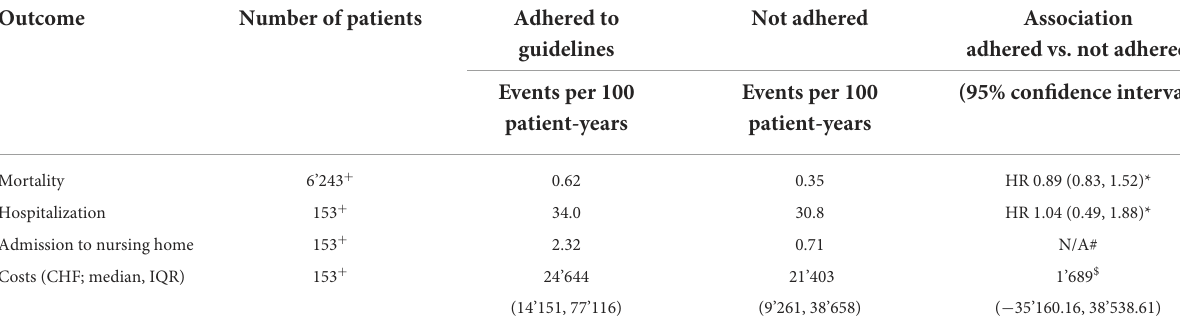
TABLE 4 Association of guideline adherence with clinical and healthcare outcomes in patients with